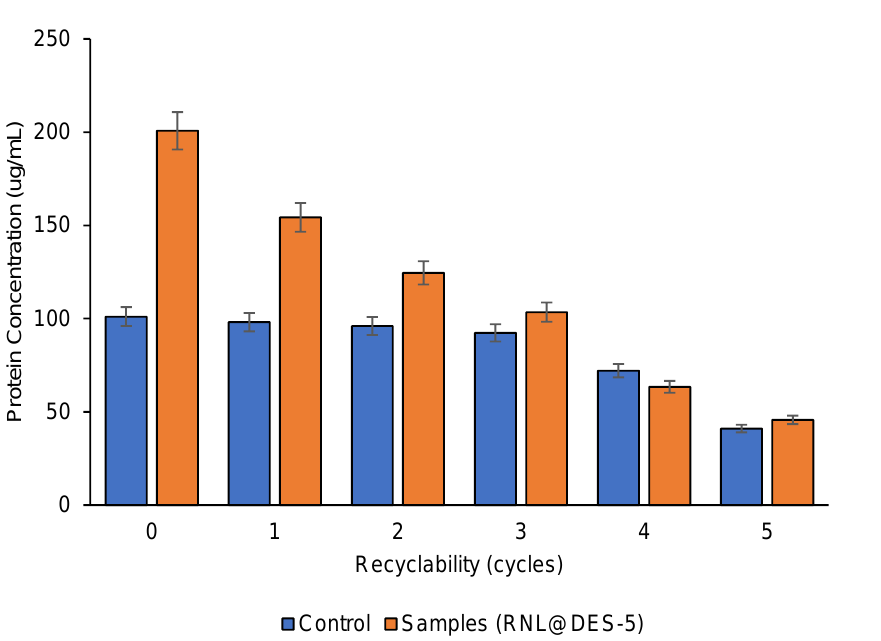
Figure 7. Recyclability of RNL (control) and RNL@DES-5 (sample). DES5 = menthol:decanoic acid (1:1) and RNL = Rhizopus niveus lipase. Conditions: concentration of lipase: 1 mg mL − 1 , 2 h, 300 rpm, 40 °C, and pH 7.0.